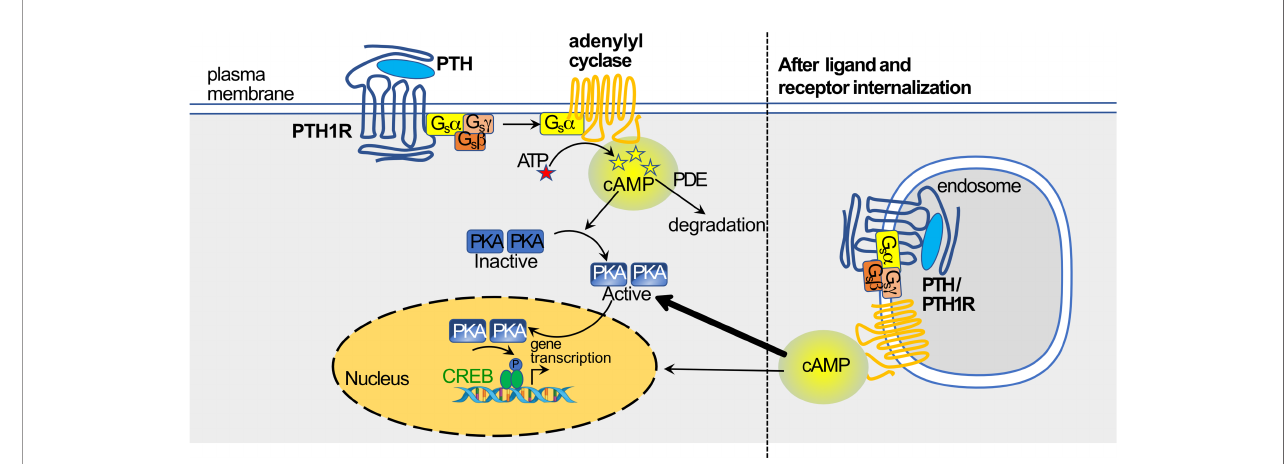
FIGURE 5 | PTH activation of cAMP/PKA pathway through PTH1R, and translocation of ligand-receptor to endosome(based on work of (86, 87), fi gure modi fi ed from (37) with permission) (see text for